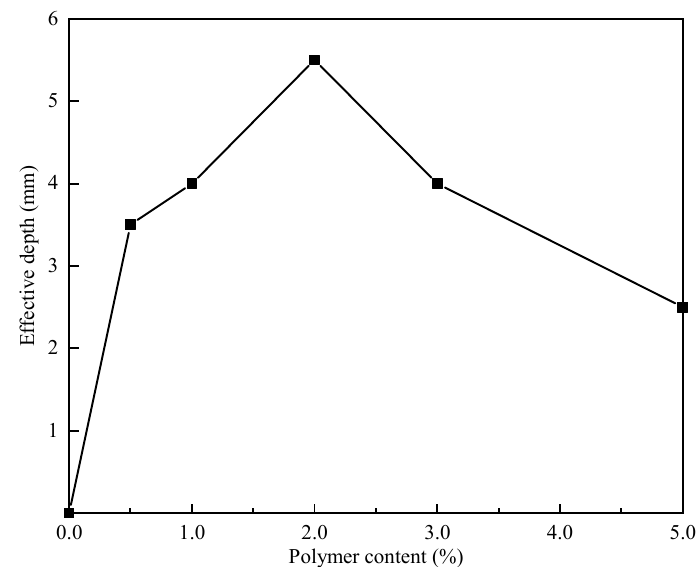
Figure 4. The effective infiltration depth of ADNB.